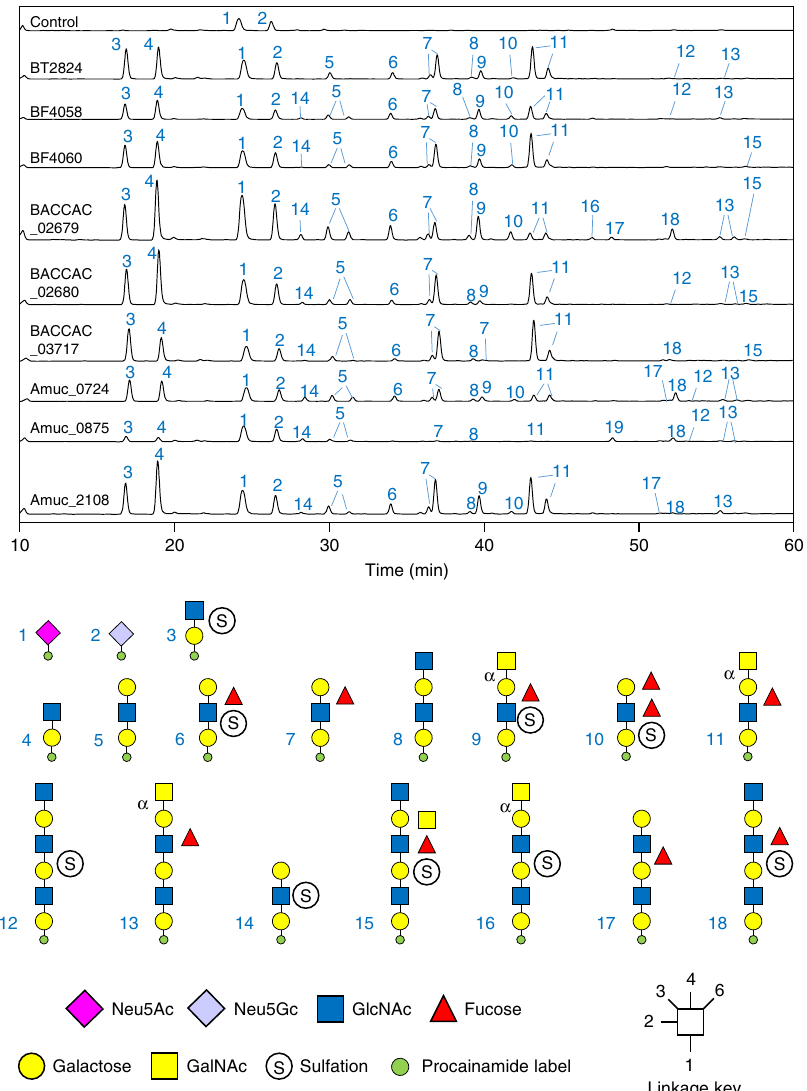
Fig. 3 Activity of the GH16 O-glycanases against porcine small intestinal mucin. SI mucin was incubated with the GH16 enzymes alongside a broad- acting sialidase (BT0455 GH33 ). The control is sialidase-only. Products of small intestinal mucin digestion were labelled with procainamide at the reducing end and analysed by LC-FLD-ESI-MS. The results show a variety of oligosaccharides are released by the GH16 enzymes and majority are similar between the samples. The oligosaccharides have a variety of fucose and sulphate decorations. Species capped with α -GalNAc were determined using exo-acting enzymes speci fi c to that sugar and linkage (see Supplementary Fig.